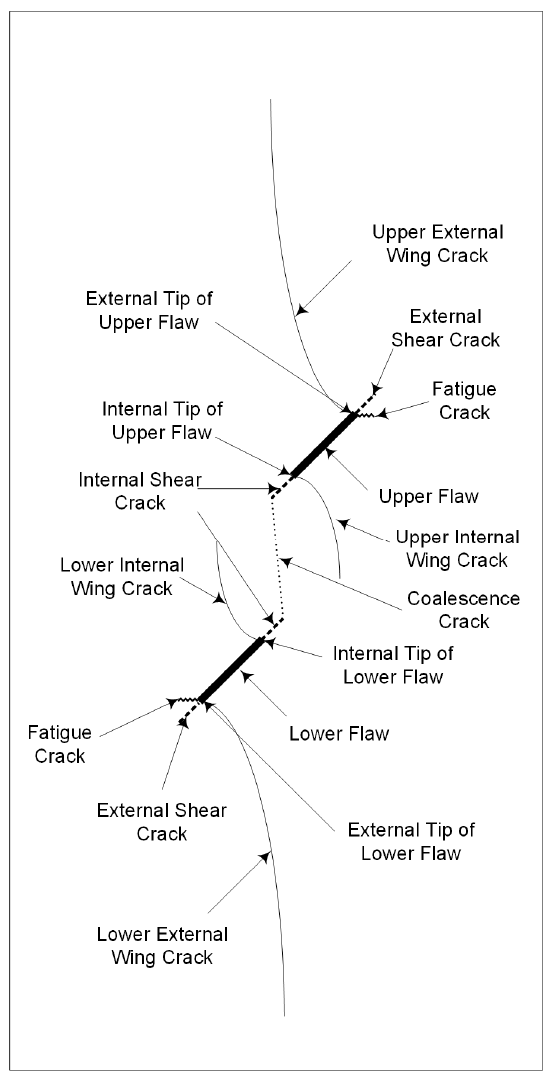
Figure 4. General crack patterns observed in the test.